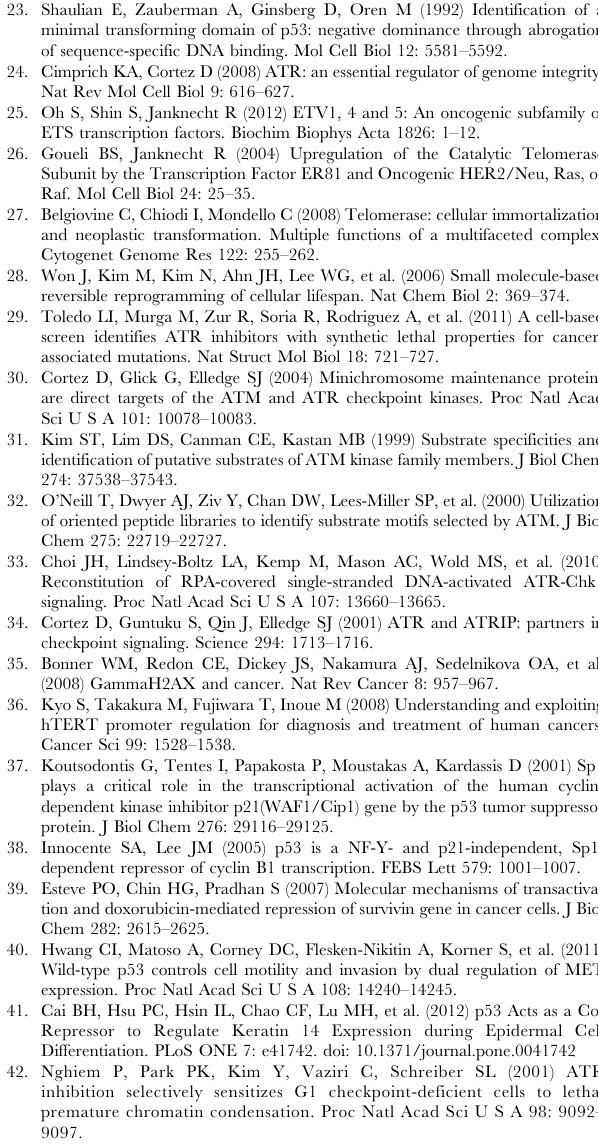
Table S4 Oligo ID numbers and locations for shRNAs obtained from Open Biosystems, sequences of synthesized siRNAs, and primer sequences for qRT-PCR